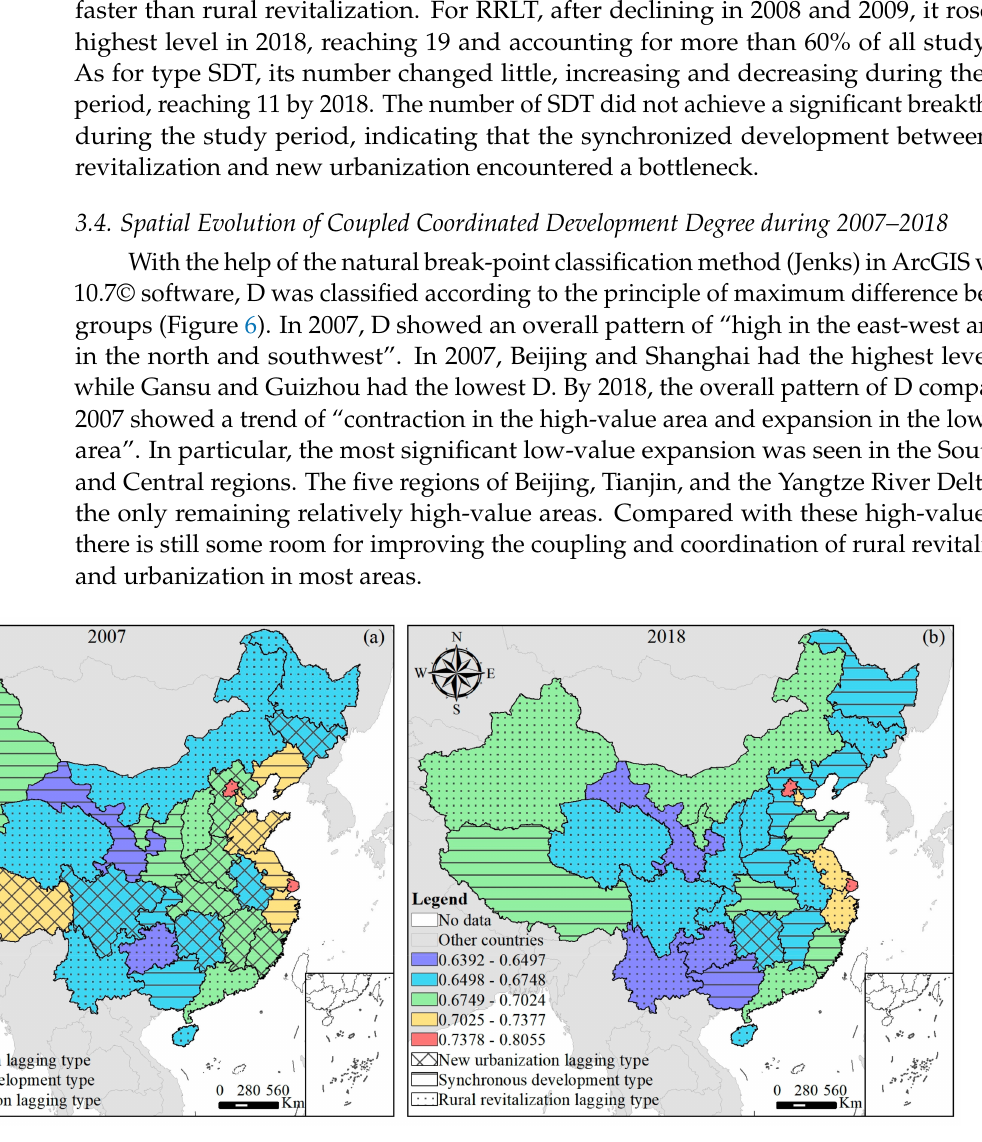
Figure 6. ( a , b ) Spatial and temporal evolution of coupling coordination degree during 2007–2018. (Source: made by